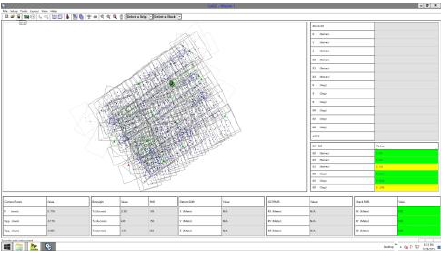
Figure 7: CalQC bundle adjustment project